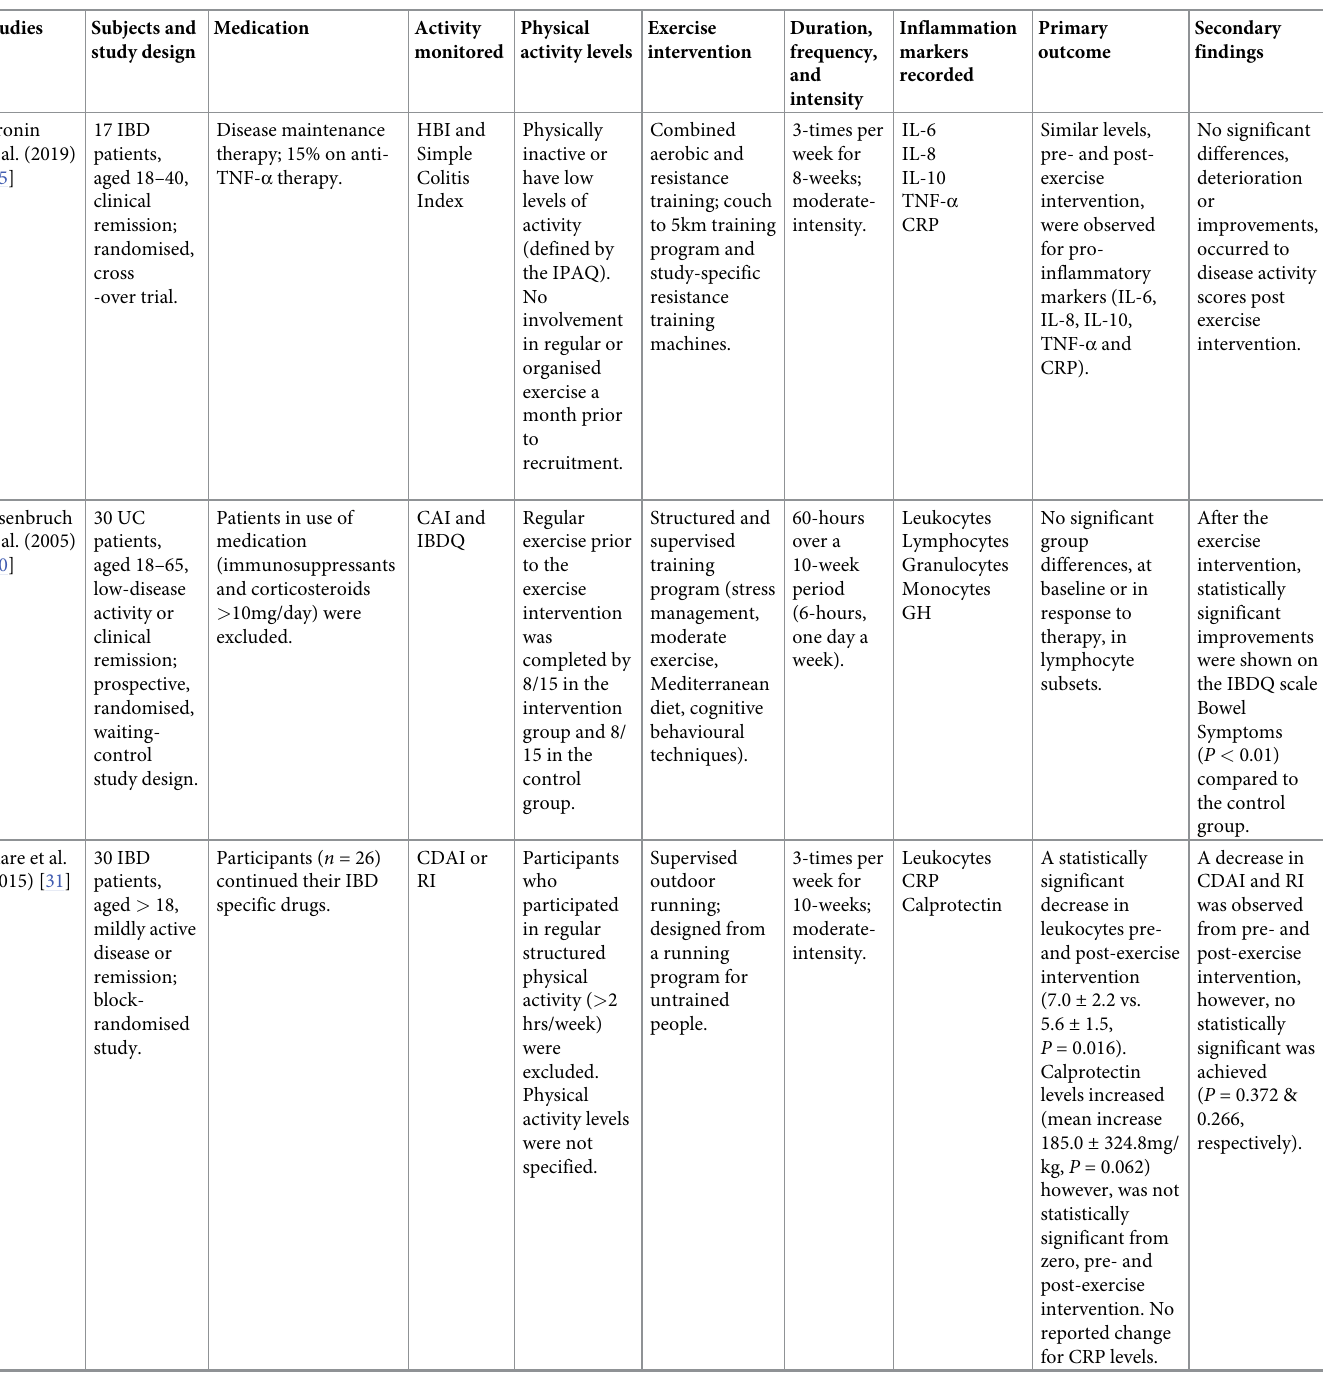
Table 2. Characteristics of Included